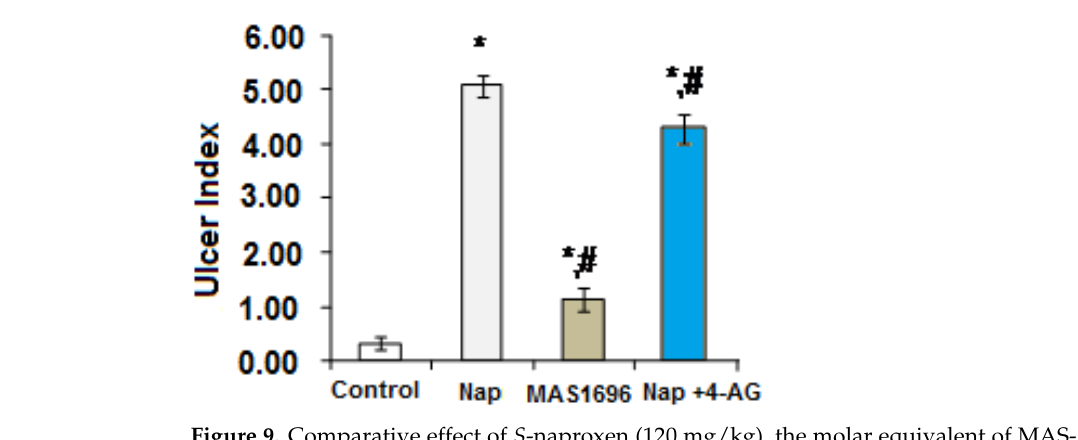
Figure 9. Comparative effect of S -naproxen (120 mg/kg), the molar equivalent of MAS-1696, and S -naproxen and 4-allyl guaiacol physical mixture (Nap + 4-AG) on gastric damage in the stomach. * p < 0.05 vs. vehicle-treated group; # p < 0.05 vs. naproxen-treat group. Results presented are mean ± S.E.M. of six animals in each group.